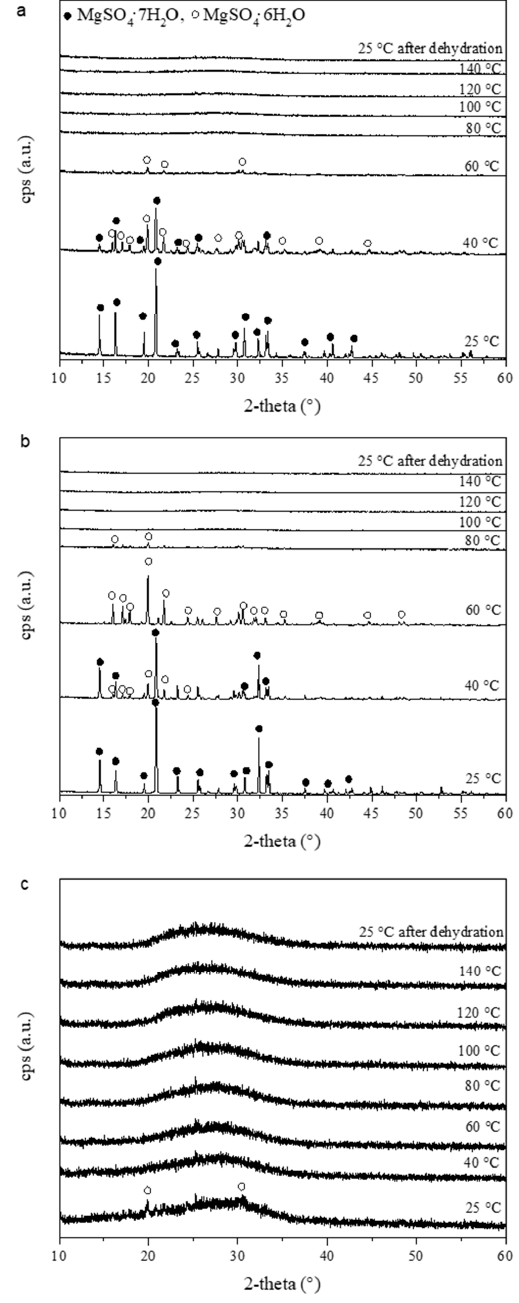
Figure 3. Temperature programmed X-ray diffraction (XRD) analysis in air, dehydration temperature rate 1 °C/min ( a ), 10 °C/min ( b ), in vacuum ( c ).